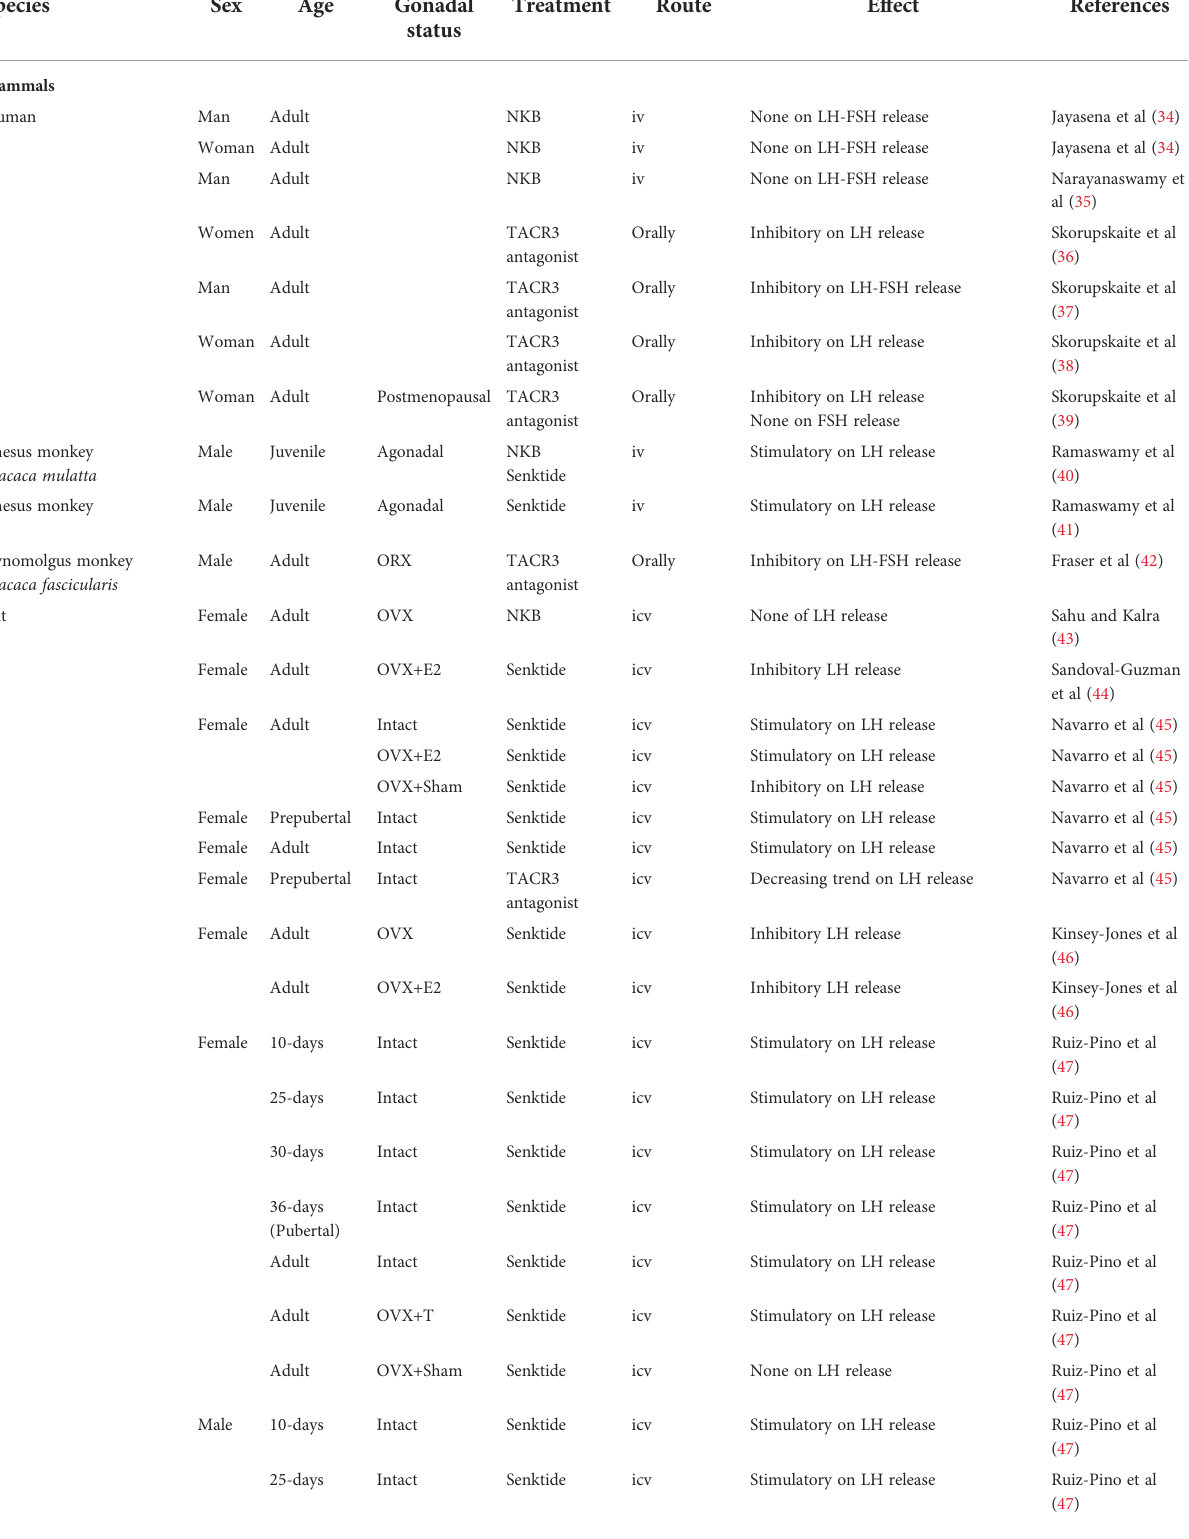
TABLE 1 In vivo studies concerning NKB action on gonadotropins in mammals and teleosts.